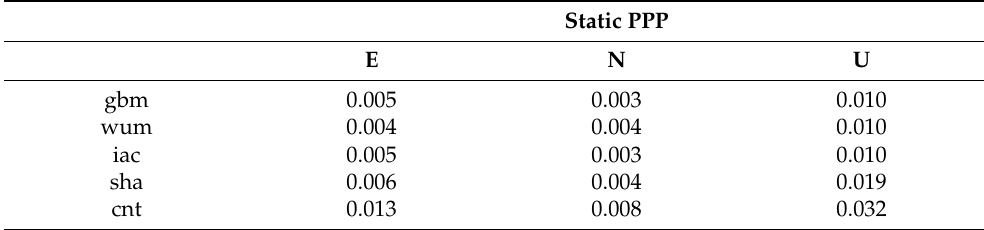
Table 6. The 25th percentile of positioning accuracy (unit: m) in ENU directions derived from BDS-3 PPP in static mode with five precise products.